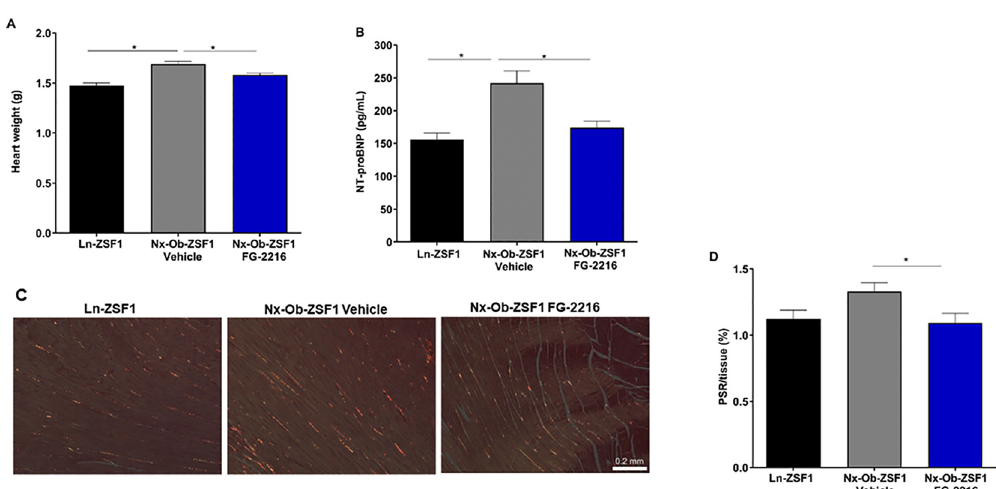
Fig 8. FG-2216 reduced cardiac hypertrophy in Nx-Ob-ZSF1 rats. Hearts were harvested and weighed after 18 weeks of treatment. FG-2216 normalized heart weight in Nx-Ob-ZSF1 rats ( A ). Blood was collected from rats to measure plasma levels of NT-proBNP after 16 weeks of treatment. FG-2216 normalized NT-proBNP concentration in Nx-Ob-ZSF1 rats ( B ). Cardiac histology with picrosirius red (PSR) staining for fibrillar collagen showed left ventricular fibrosis ( C ). FG-2216 decreased PSR staining in Nx-Ob-ZSF1 rats ( D ). Values represent mean ± SEM (n = 8–12). � P < 0.05 vs . Nx-Ob-ZSF1 Vehicle (Dunnett’s